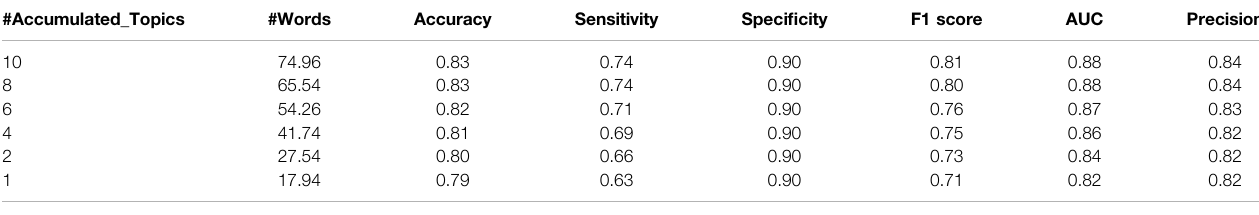
Bold values represent the highest values in each metric column.